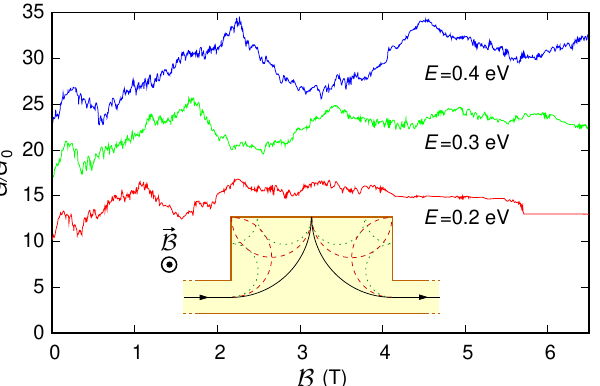
Figure 10. Conductance G , normalized with respect to the conductance quantum G 0 , which was obtained as a function of the orthogonal magnetic field B for the structure represented in the inset, keeping the Fermi energy E constant at 0.2 eV (red line), 0.3 eV (green line), and 0.4 eV (blue line). In the inset, we represent also the three cyclotron trajectories that give rise to the first three conductance